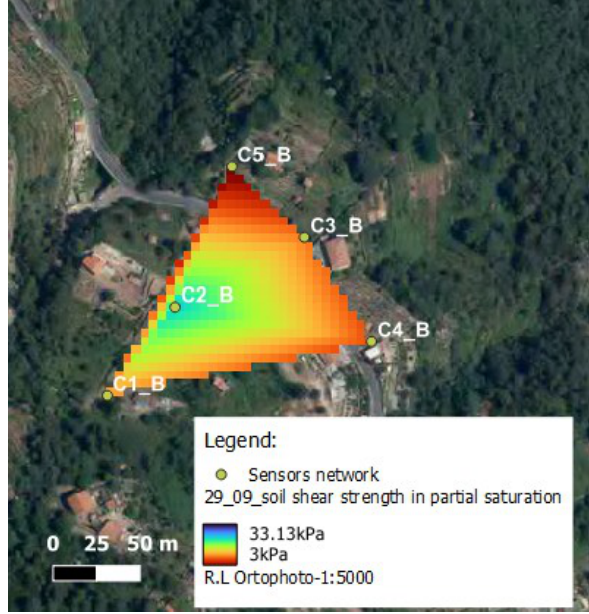
Figure 8. The shear strength surface induced by partial saturation referring to 29/09/2020, a dry day between the two analysed